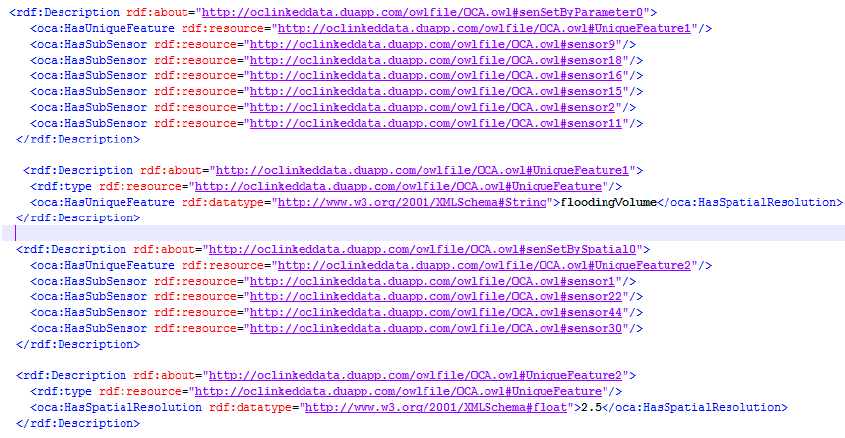
Figure 11. A part of an RDF-described static observation capability association instance.